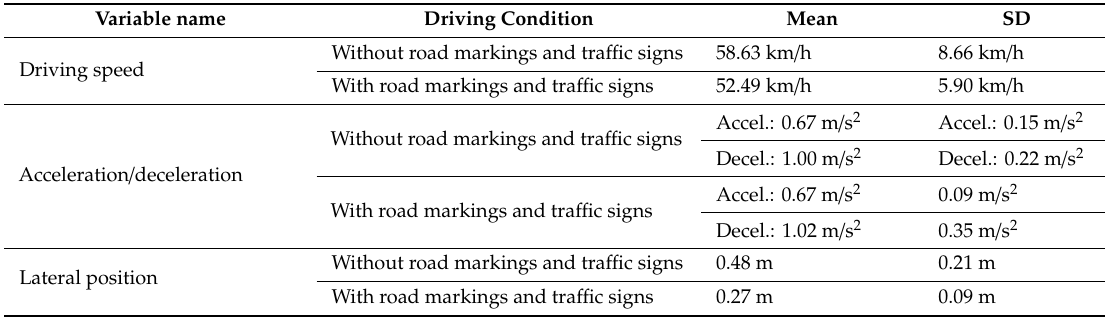
Table 4. Summary of the